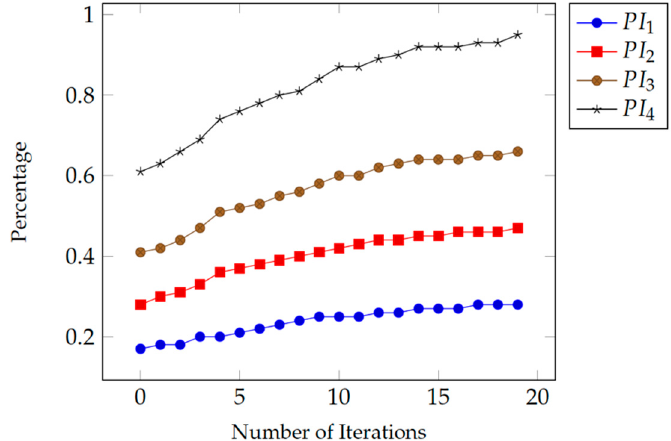
Figure 4. Different values for the performance index, by implementing Equation (9). The lower line presents a static value of C = 3 and K = 7. The second line present an equal value for C = K = 5. The third line presents a static value of C = 7 and K = 3. The upper line presents the values of C = 10 while K = 0.